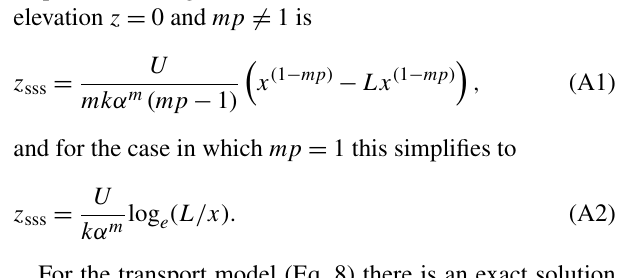
Table A1. Gradient, θ , of the slope vs. area trend at steady state for 1-D sediment transport (Eq. 8, Fig. A2). δ p = 1 .